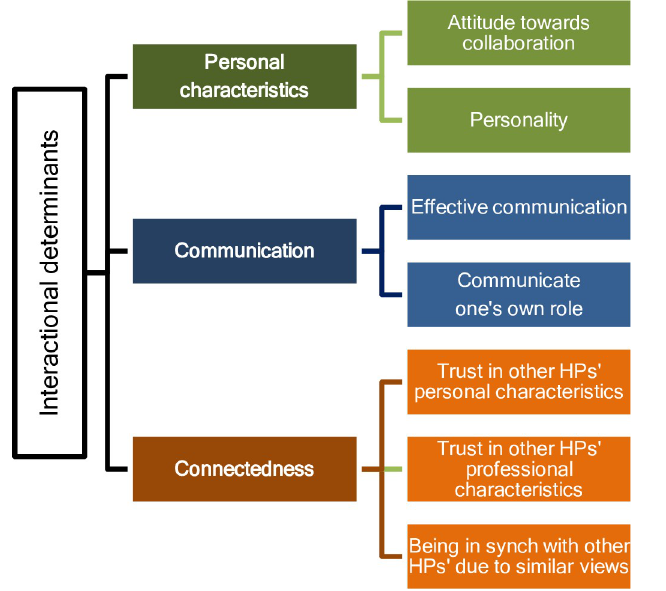
Fig 1. Themes summarizing interactional determinants to